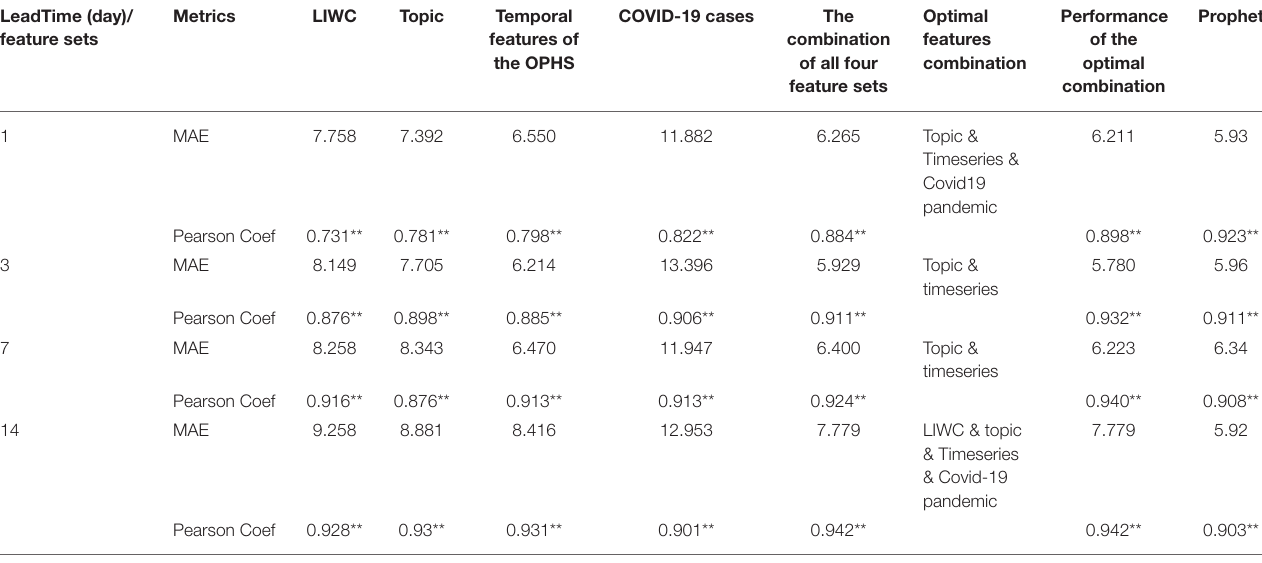
Metrics LIWC Topic Temporal